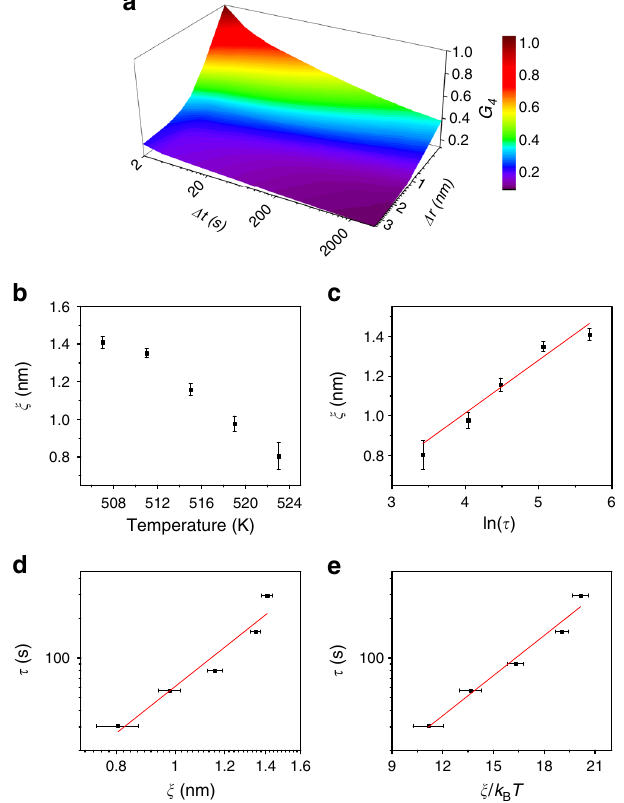
Fig. 4 Characteristic length and time scale for heterogeneous dynamics. a An example g 4 ( Δ t , Δ r ) at 507 K. b The correlation length ξ as a function of temperature. c ξ vs. ln( τ ), which is a straight line in the Adam-Gibbs theory. 15 d A log – log plot of ξ vs. τ , which is a straight line in the inhomogeneous mode-coupling theory 54 . e A semi-log plot of τ vs. ξ / k B T , which is a straight line in the random fi rst-order transition theory 14 . The data are in reasonable agreement with all of the models. The reduced χ 2 is 0.914, 0.905, and 0.961 for the fi tting in c , d , e , respectively. The error bars are the standard deviation of the mean of four measurements on different